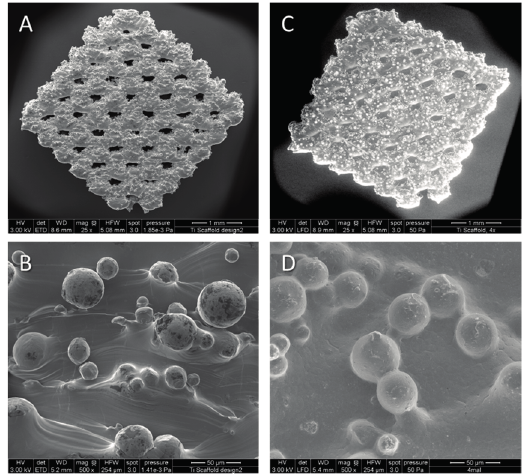
Figure 1. Representative Environmental Scanning Electron Microscopy (ESEM) micrographs of non-coated ( A , B ) and polycaprolactone (PCL)-coated ( C , D ) porous titanium scaffolds in overview and